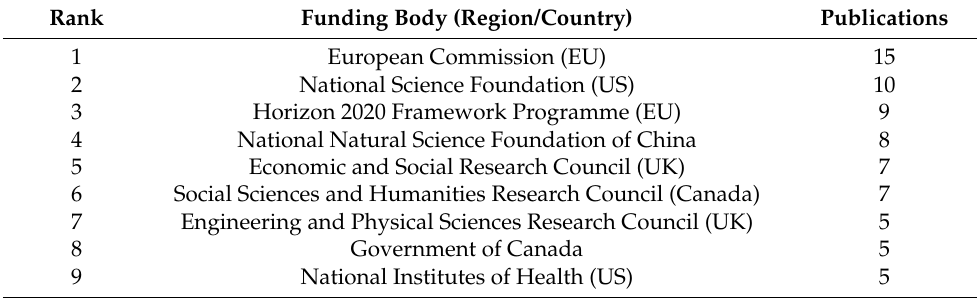
Table 3. Top funding sponsors (supporting five publications or